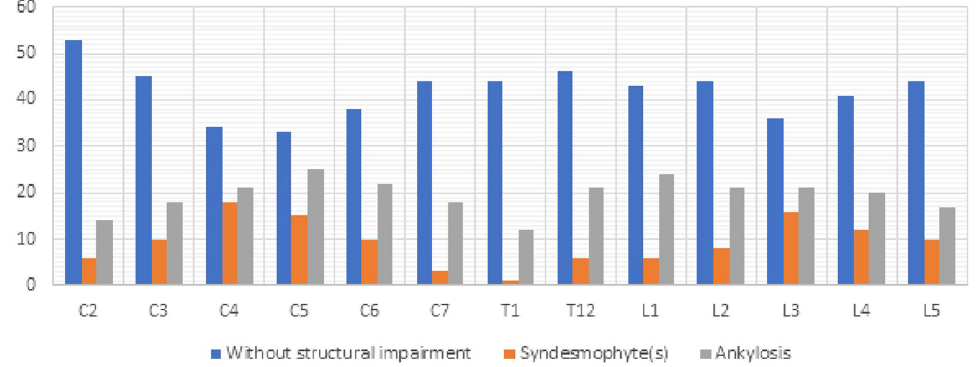
Figure 2. Spine structural lesions for each vertebra issued from mSASSS